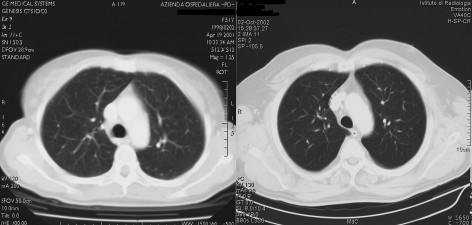
Computed tomography scan after the end of the interferon treatment. Computed tomography scan for DD/DI patient (left) and HDI patient (right) performed after the end of treatment showed the disappearance of radiographic infiltrates.